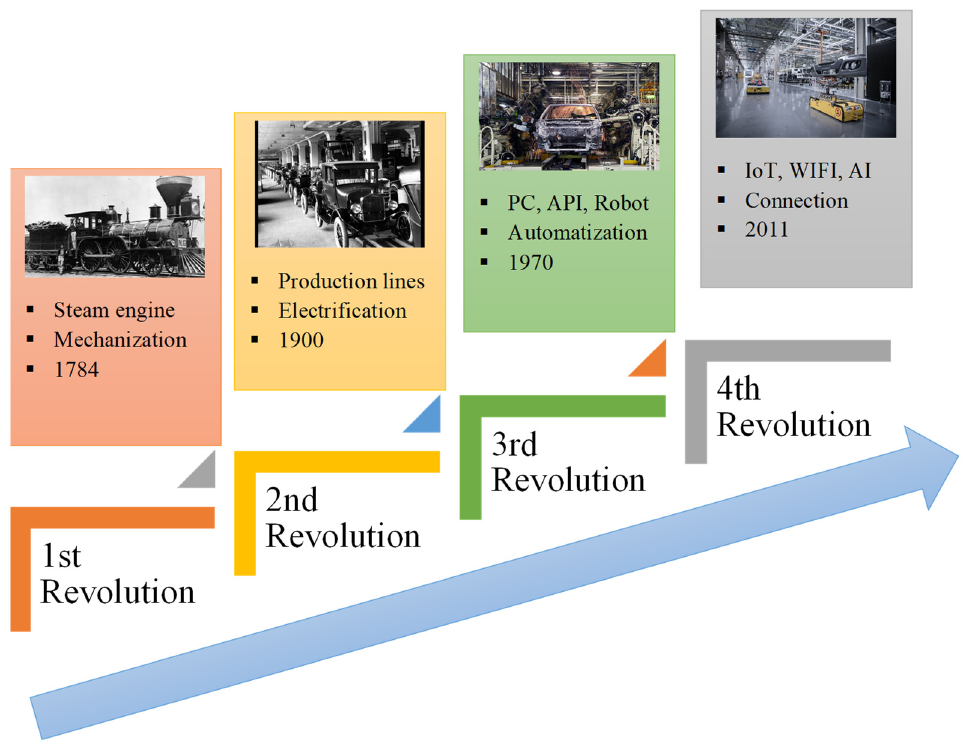
Figure 2. The four industrial revolutions.